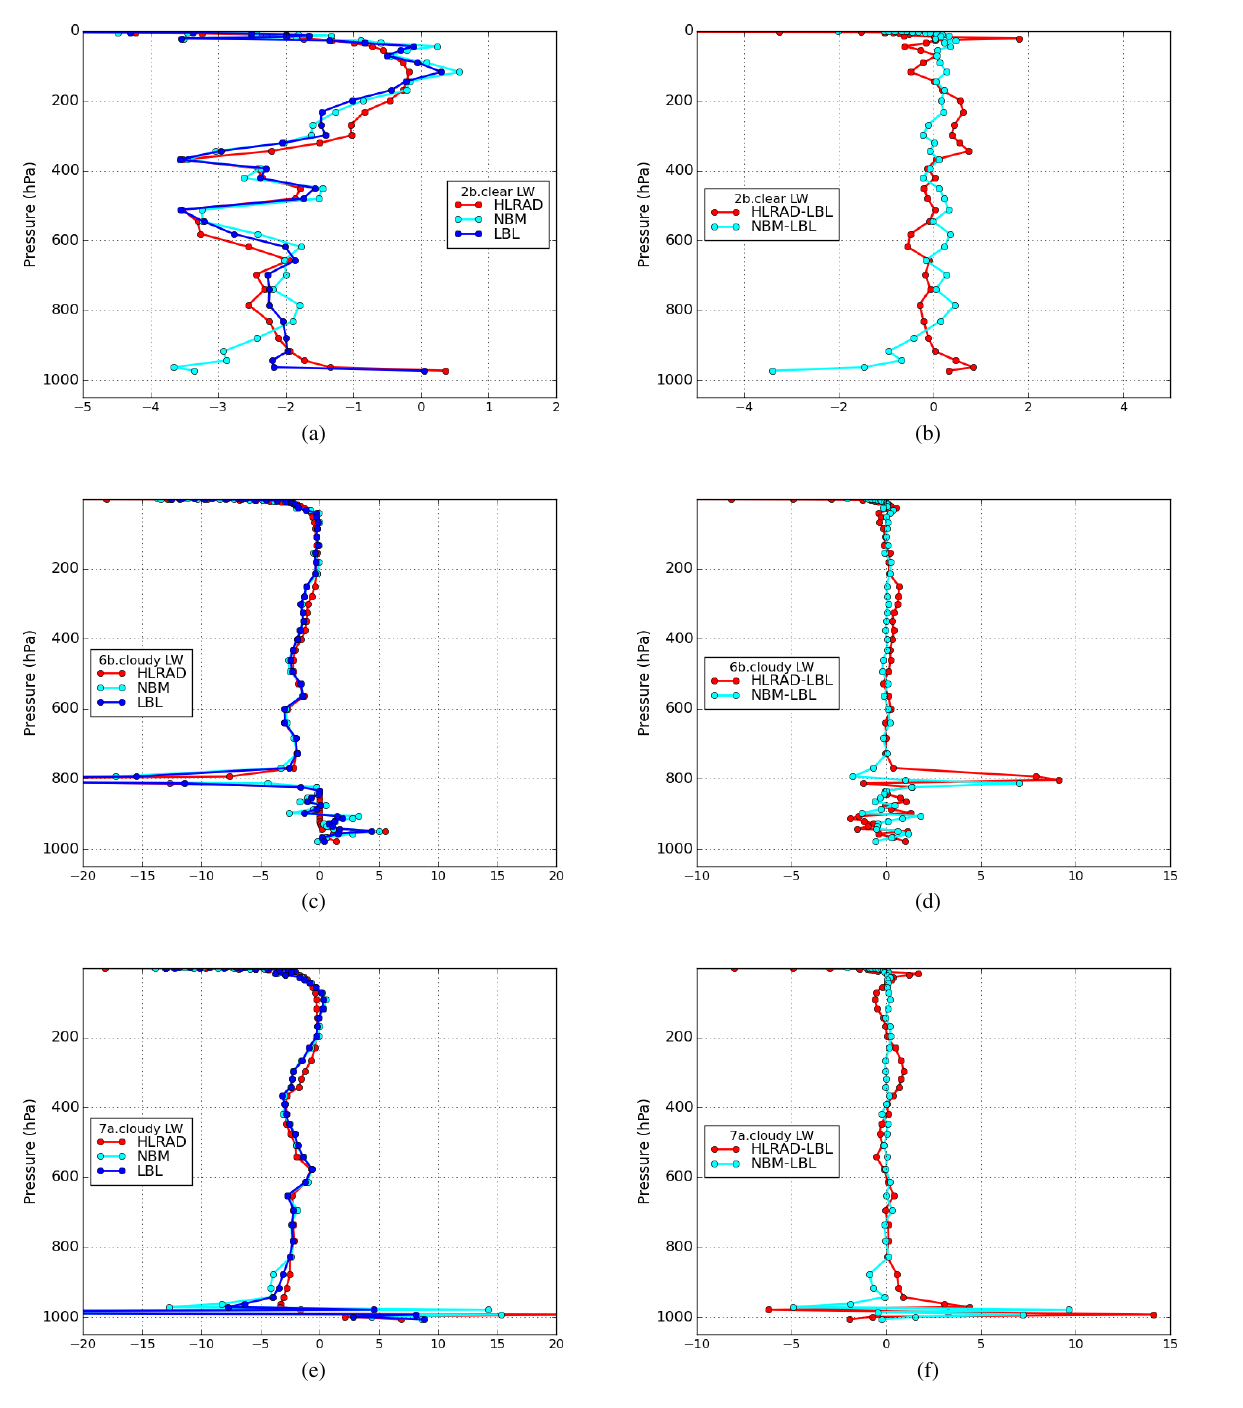
Figure 3. As for Fig. 2 but for LW heating rate (unit Kday − 1